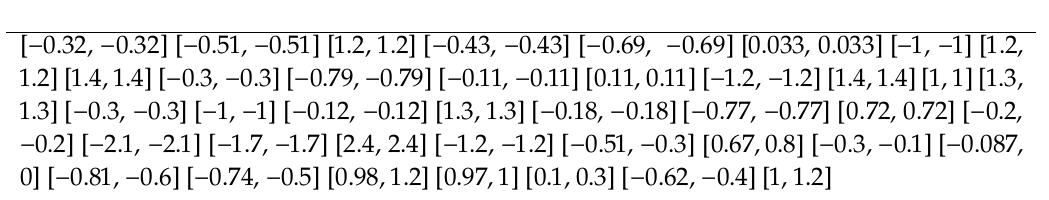
Table 1. Neutrosophic independent data from normal distribution.